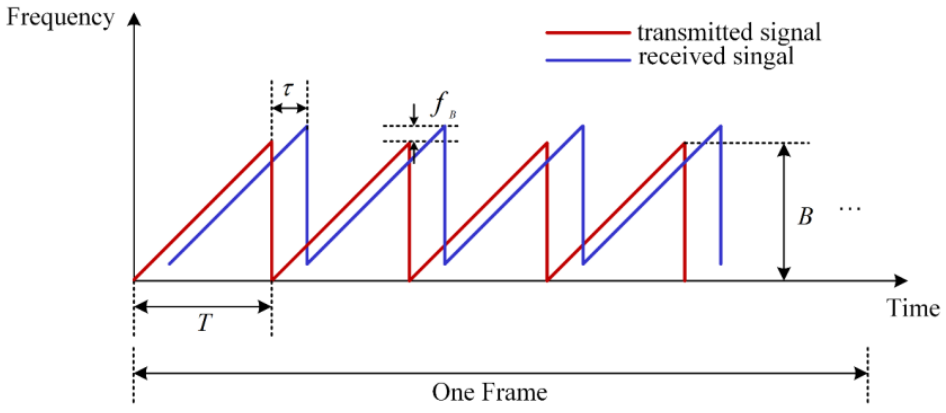
Figure 2. FMCW radar waveform in the TF domain.